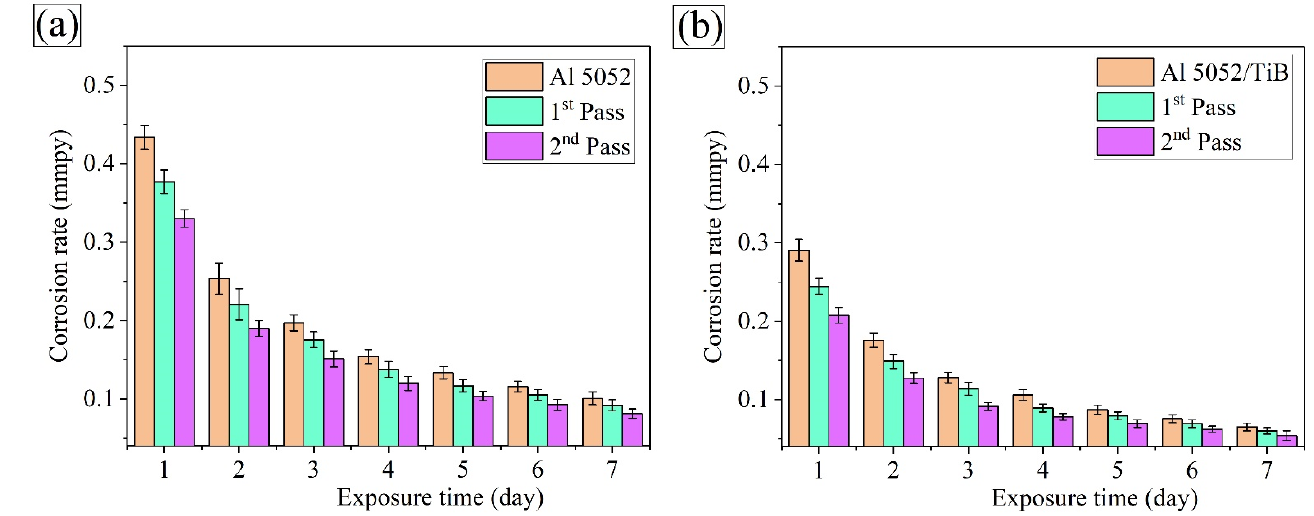
Figure 15. Corrosion rate of the investigated samples (a) Al 5052 and (b) Al 5052/TiB.